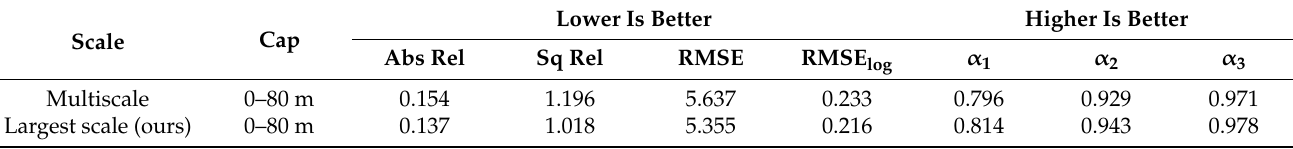
Table 1. Baseline comparisons between multiscale and largest scale supervision, where Cap represents the range of valid depths. The best results in each category are in bold. Refer to Section 3.3 for the meaning of evaluation metrics. α i = δ < 1.25 i